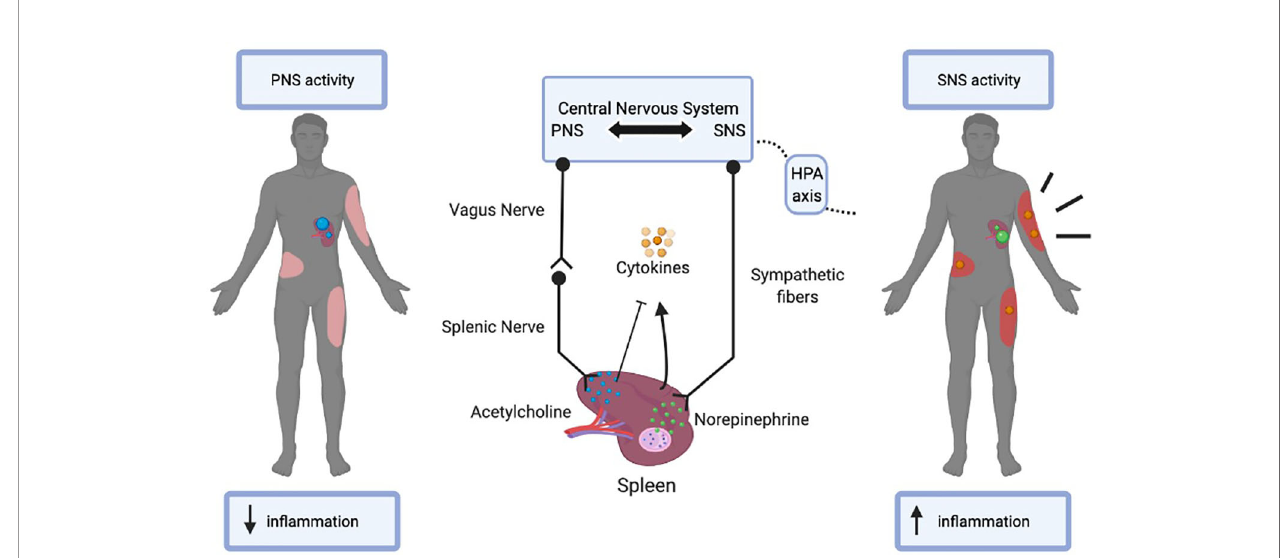
FIGURE 2 | The Ebb and Flow phases of burn injury. The Ebb phase lasts for 24-48 post-burn injury whereas the fl ow phase may last up to 2 years. The fi gure illustrates the differential systemic and metabolic response in the ebb versus fl ow phase in burn patients. Tumor necrosis factor-alpha (TNF a ), Interleukin 1 (IL-1), High mobility group box 1 (HMGB1), Secreted Ly-6/uPAR-related protein 1 (SLURP1), Cholinergic Receptor Nicotinic Alpha 7 Subunit